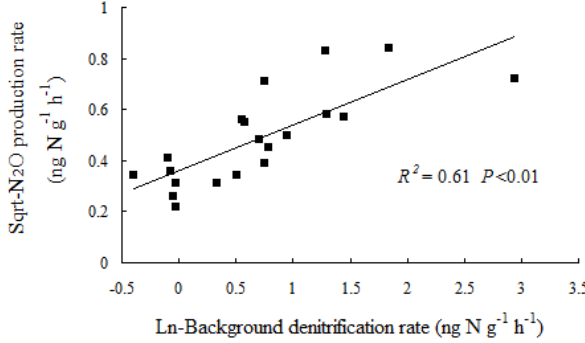
Figure 2. Relationships between background denitrification rate and N 2 O production rate of the Yangtze lakes ( N =